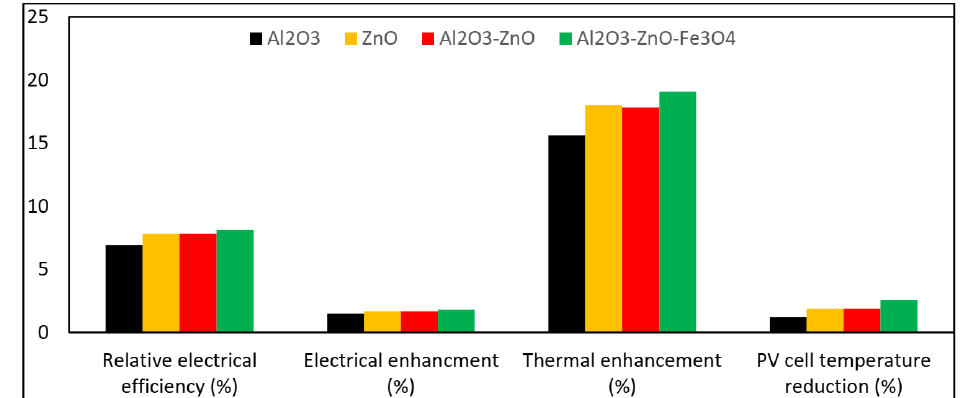
Figure 16. Comparative enhancement of different nanofluids considered.